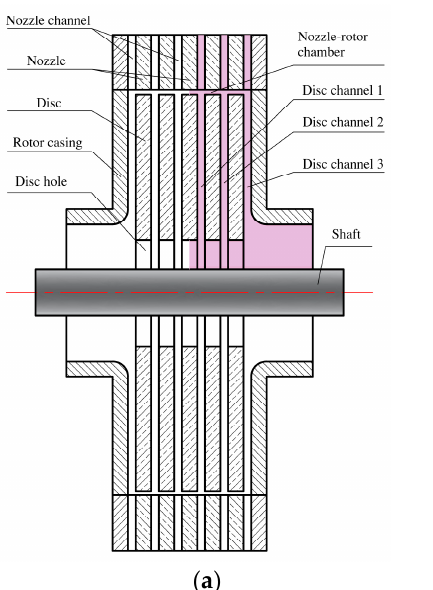
Figure 3. Schematic diagram of the one-to-many Tesla turbine with sharp disc tips.